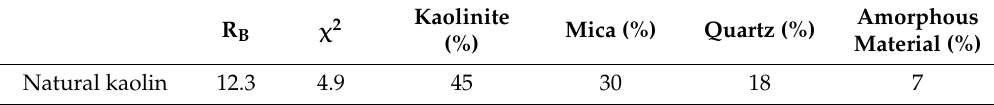
Figure 2. XRD analysis from kaolin + 1% ZnO calcined at 600 ◦ C and 750 ◦ C for 2 h. Table 3. Quantification of all the phases present in natural kaolin using the Rietveld method.